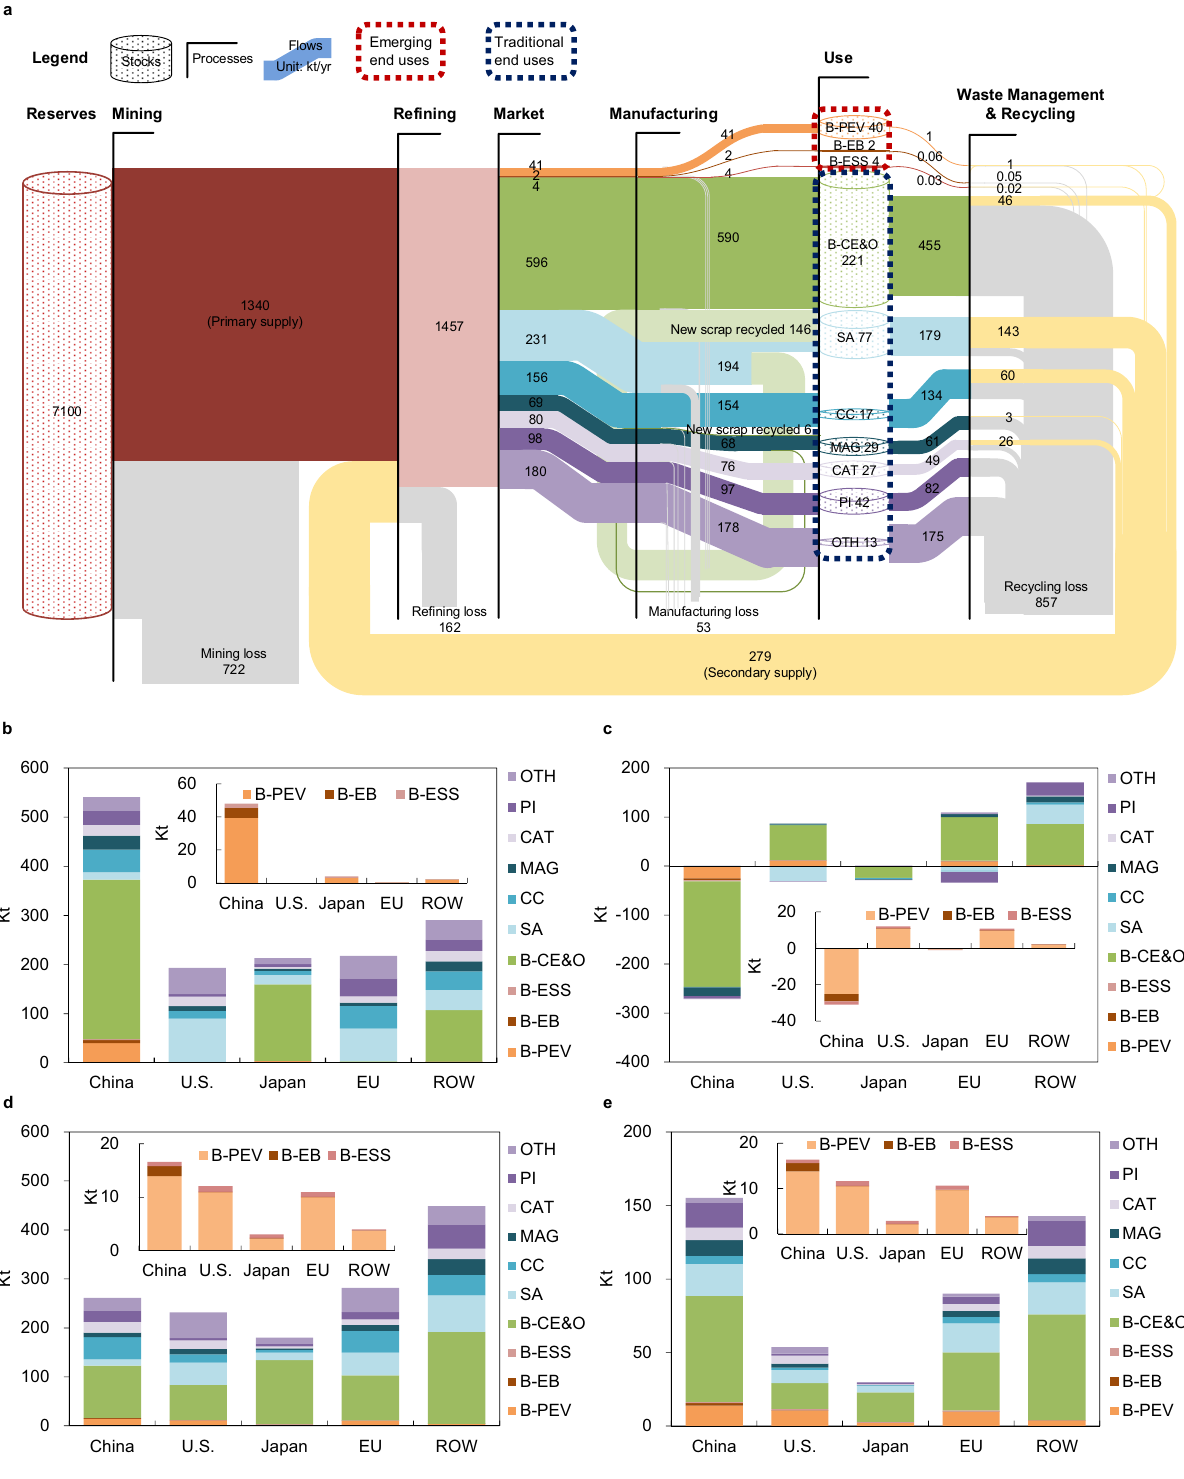
Fig. 2 Historical cobalt stocks and fl ows at global and regional scales, 1998 – 2019. a Cumulative global cobalt cycle, b cumulative cobalt apparent consumption (in fl ows to manufacturing) by sector by region, c cumulative net import (positive values) and net export (negative values) of cobalt- containing fi nal products by sector by region, d cumulative demand (in fl ows to in-use stocks) by sector by region, and e in-use stocks by end use by region in 2019. All values are in metric kilotons as cobalt metallic